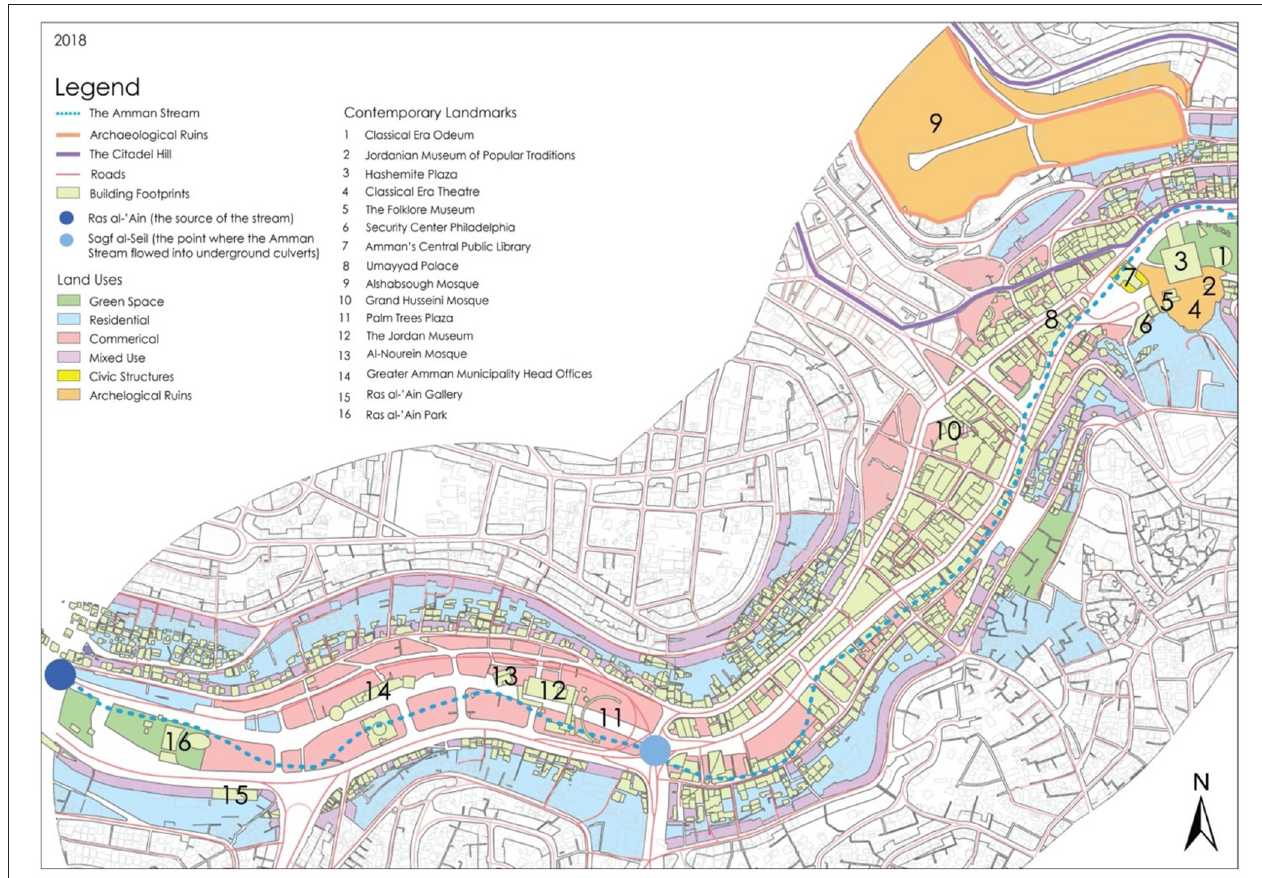
FIGURE 13 | The spatial traces of the Amman Stream persist in the urban landscape (map produced by Sophie Wang under the supervision of Dr. Luna